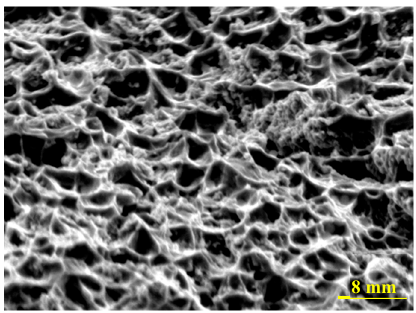
Figure 10. Fracture morphology of coating.